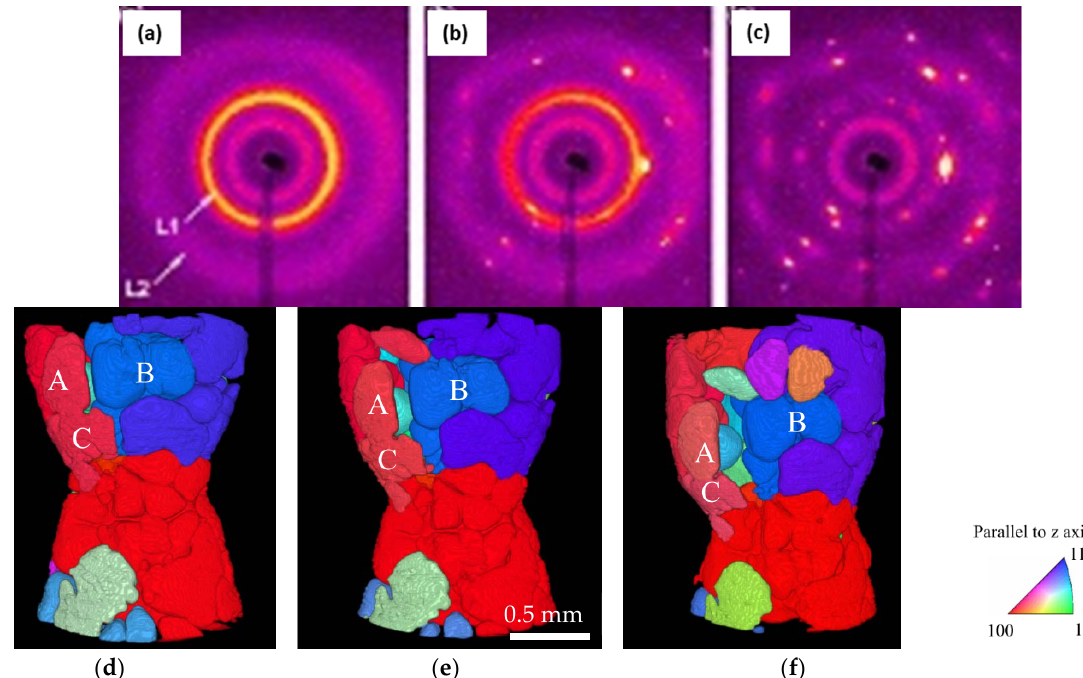
Figure 10. ( a – c ) X-ray diffraction patterns of the aluminium alloy with titanium solute (0.1 wt.%) and added TiB 2 particles (0.1 wt.%) at different stages ( a – c ) of the solidification process (after Iqbal et al. [147]). Collected during cooling from 973 K at a rate of 1 K/min; ( d – f ) show the crystallographic orientation of the 3D-reconstructed solid grains in the equiaxed Al– 10 mass% Cu alloy at the strains of ( d ) − 0.04, ( e ) − 0.06, and ( f ) − 0.13; where the color variation indicates the crystallographic orientation as detected by 3DXRD, after Narumi et al. [146]. Permitted for reuse from respective